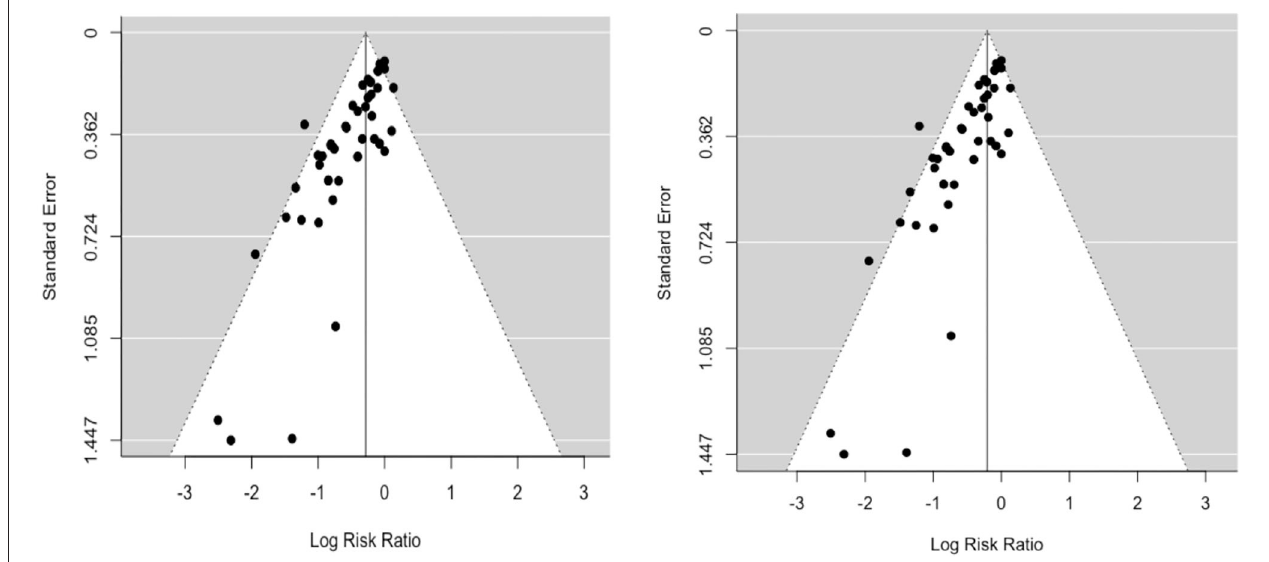
FIGURE 2 | Funnel plots (left: RE; right: FE) of the log risk ratio against standard error demonstrate potential publication bias.